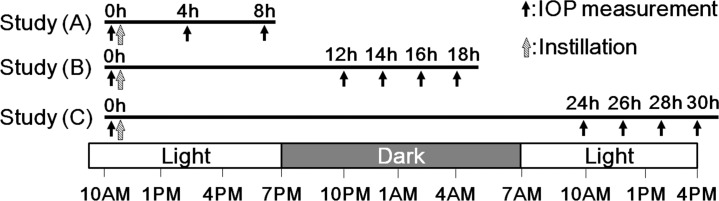
Timeline of the three studies of Taf/T-FDC and Lat/T-FDC in ocular normotensive monkeys.Three independent IOP studies were performed for the comparison of the IOP-lowering effects of Taf/T-FDC and Lat/T-FDC in ocular normotensive monkeys. In all studies, drug instillations were performed at 10:00 AM to 11:00 AM. IOP measurements were performed immediately before, and at 4 and 8 h after drug instillation in study A, immediately before, and at 12, 14, 16, and 18 h after drug instillation in study B, and immediately before, and at 24, 26, 28, and 30 h after drug instillation in study C. Dark-phase IOP measurements were performed under a safelight.